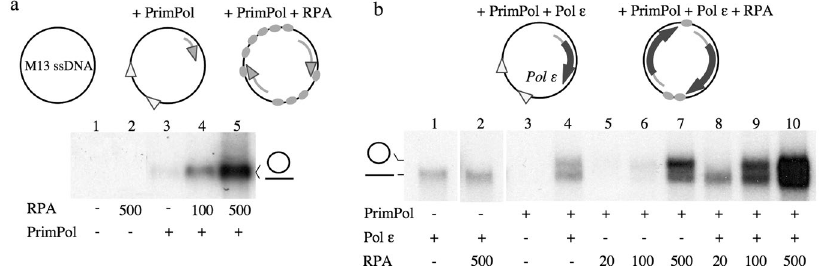
Figure 4. RPA stimulates both primase and polymerase activities of PrimPol in synergy with Pol ε . ( a ) Effect of RPA on the combined primase and polymerase activities of PrimPol in non-primed M13 ssDNA. PrimPol (200 nM) was incubated with the template M13 ssDNA 2 nM, 100 µ M of dATP, dCTP, dTTP and GTP, 16 nM [ α - 32 P] dGTP in the presence of 5 mM MgCl 2 and 100 µ M MnCl 2 as metal cofactors; when indicated, RPA was added to the reaction at a concentration of 100 or 500 nM. ( b ) PrimPol-Pol ε combined assay was carried out essentially as described in part ( a ) but using 50 µ M MnCl 2 , and when indicated adding Pol ε (10 nM) and RPA (20, 100 or 500 nM). After native agarose electrophoresis, the nature of the labelled products (circular ssDNA and linear ssDNA) was inferred from EtBr-staining of the gels prior to autoradiography. The schemes represent the stimulation of PrimPol primase and polymerase activities in the presence of RPA, and the subsequent stimulation on extension by Pol ε